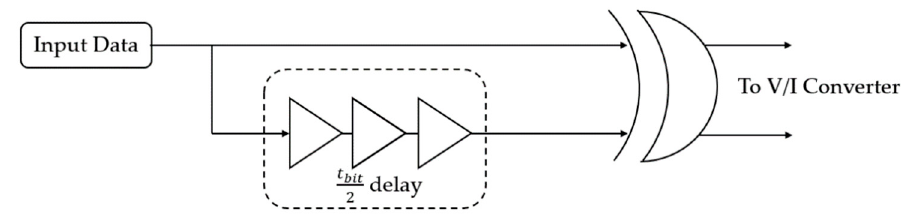
Figure 2. Pulse generator schematic.